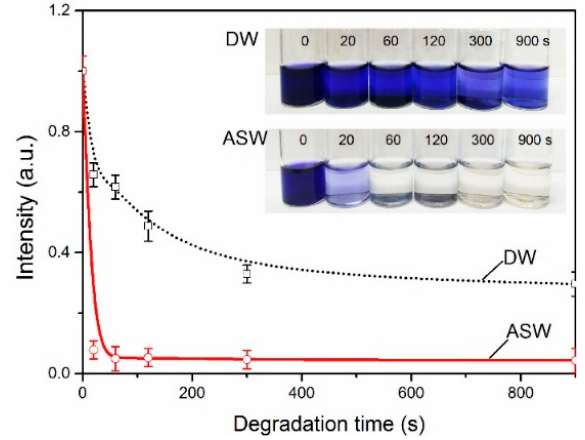
Figure 3. The normalized absorbency as a function of treatment time in the DW and ASW solution, with the inset showing the color change of the treated solutions.